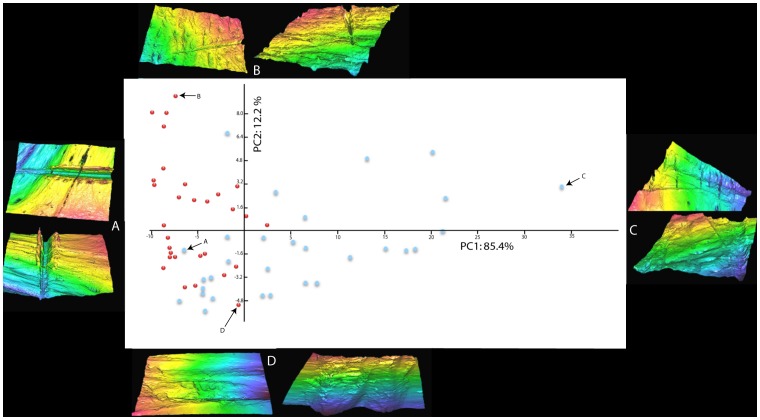
PCA using variables of measure 1a and measures 2–7.Red dots represent each terrestrial modification and blue dots represent each aquatic modification. 3D models represent within group specimens with the highest loadings on each principal component. A and C represent aquatic and D and B represent terrestrial modifications.